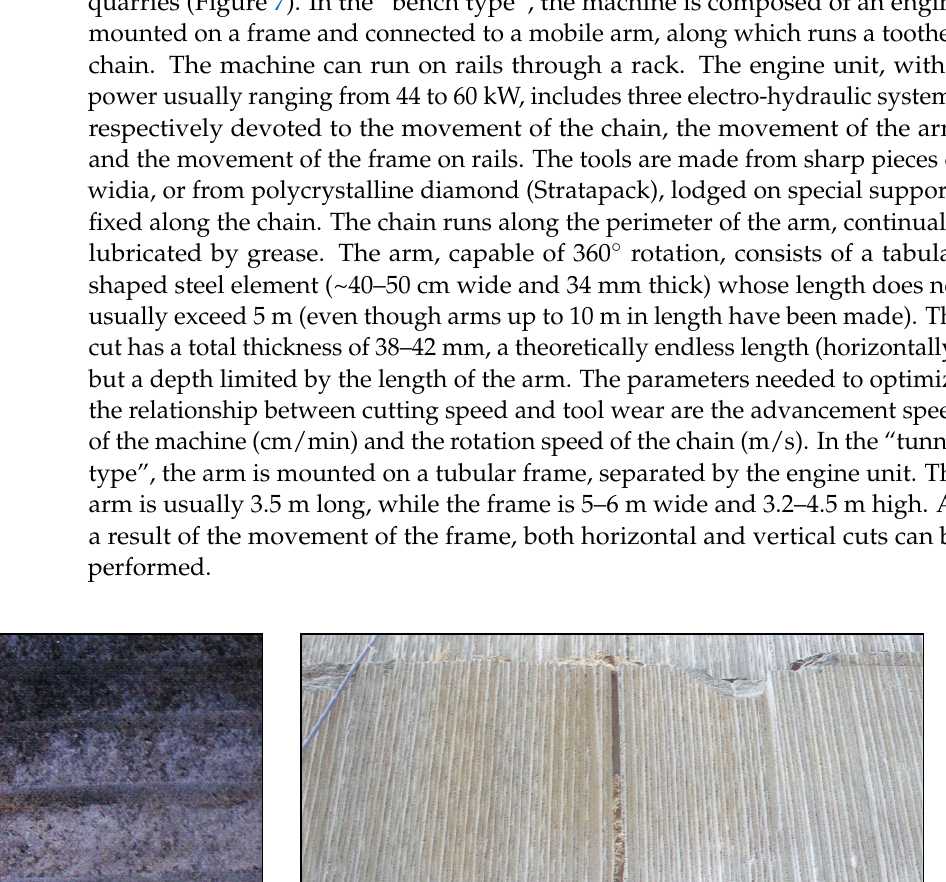
Figure 5. ( a ) Drilling of contact holes in granite using the line-drilling technique; ( b ) a granite quarry face cut with line drilling [8].